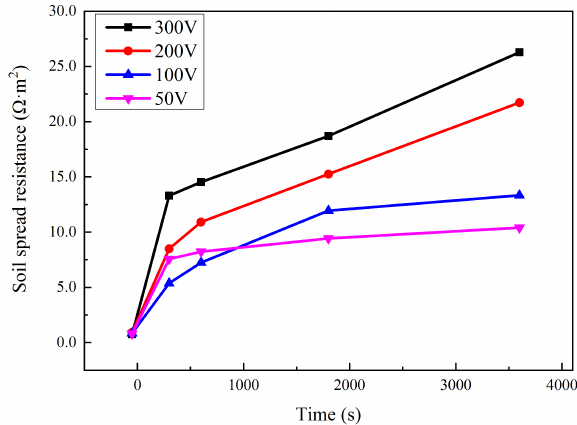
Figure 6. Variation of R s during HVDC